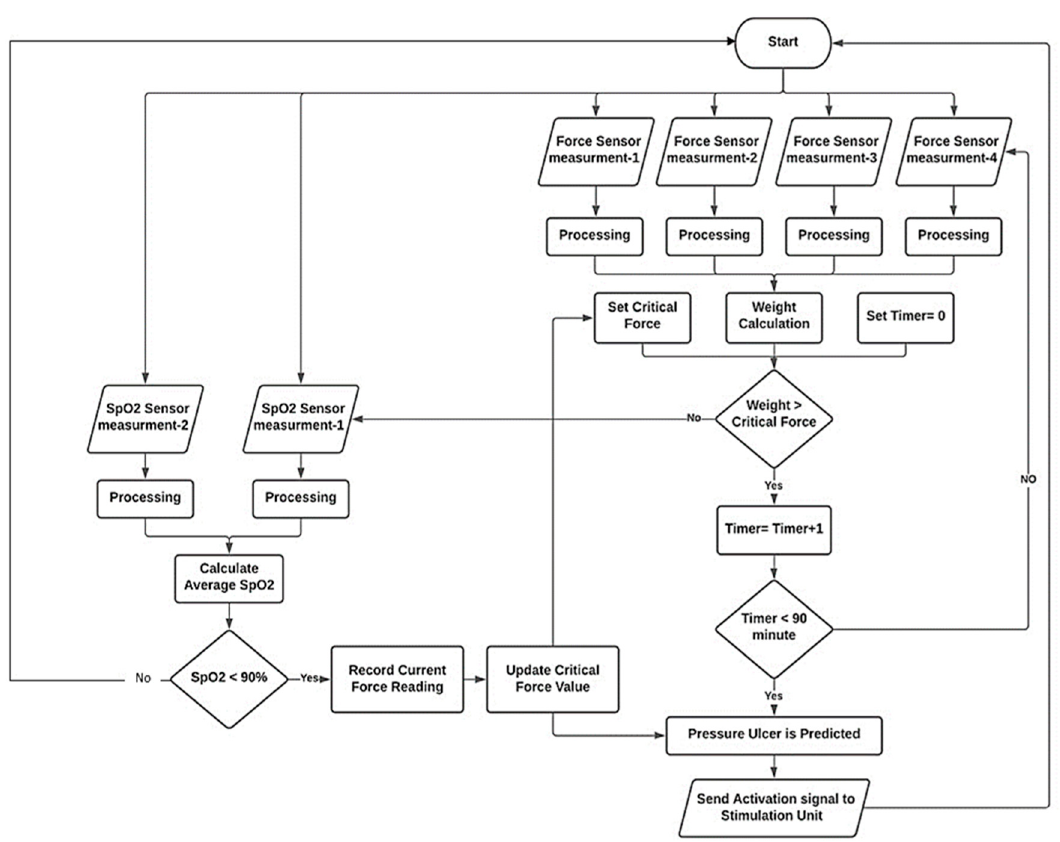
Figure 5. Pressure ulcer prediction algorithm structure.